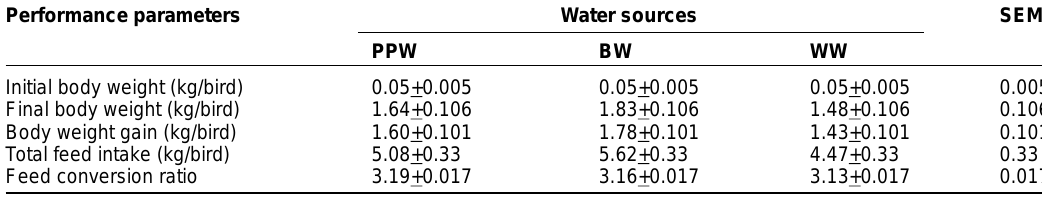
Table-3. Performance of broiler chickens given different sources of water Performance parameters